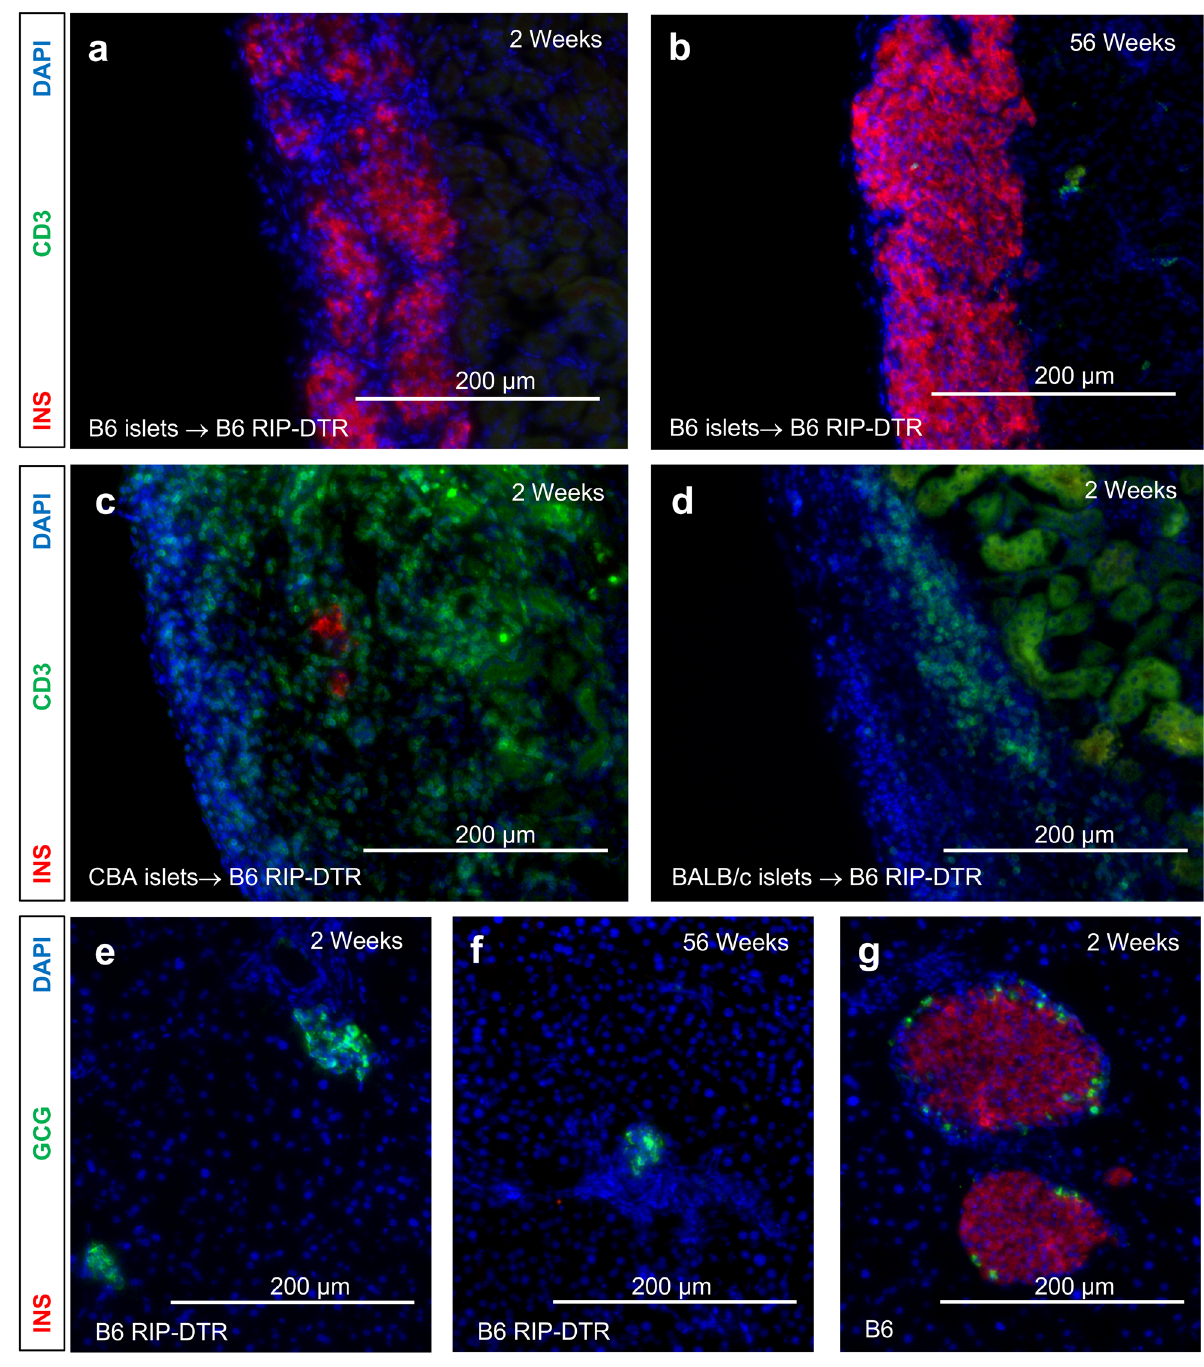
Figure 4. Histological assessment of transplanted and pancreatic islets. ( a ) Representative histology of C57BL/6J islet graft at 2 weeks and ( b ) 1-year post-transplant into B6 RIP-DTR mice. ( c ) Representative histology of CBA/J islet graft at approximately 2 weeks post-transplant into B6 RIP-DTR mice. ( d ) Representative histology of BALB/c islet graft at approximately 2 weeks post-transplant into B6 RIP-DTR mice. ( e ) Representative histology of B6 RIP-DTR pancreas from animals transplanted with C57BL/6J islets at 2 weeks and ( f ) 1 year after single DT injection. No exogenous daily insulin was necessary due to the function of transplanted islets. ( g ) Representative histology of B6 CD45.1 pancreas (wild type) at 2 weeks after single DT injection. INS Insulin, CD3 CD3 + T cells, GCG